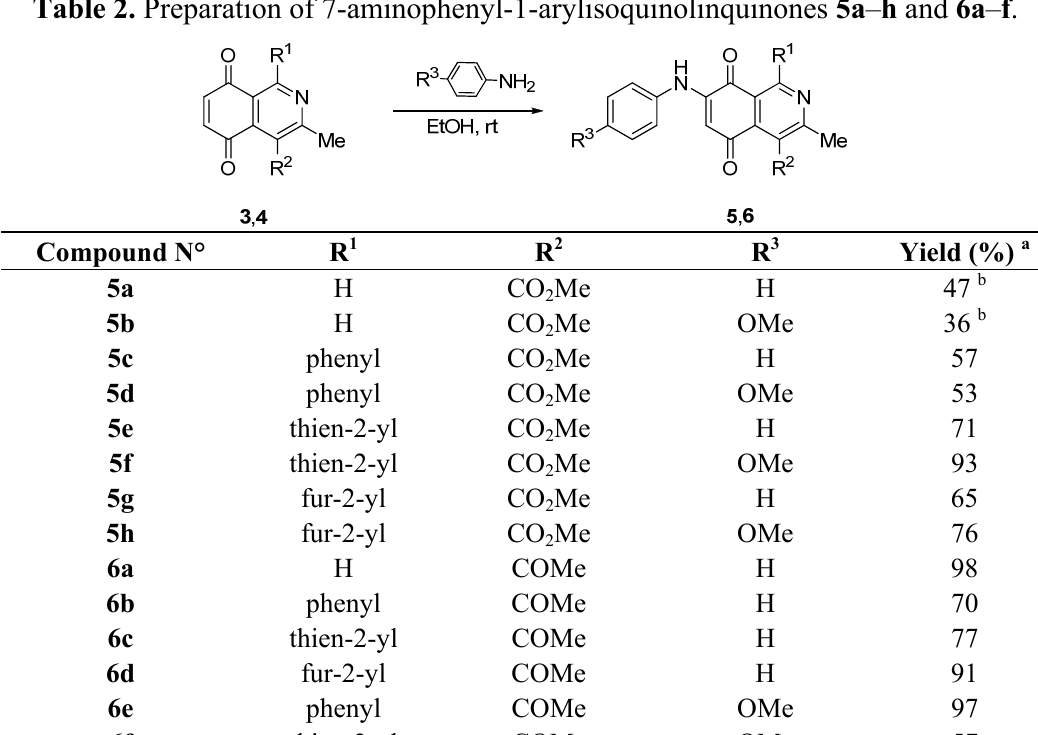
Table 2. Preparation of 7-aminophenyl-1-arylisoquinolinquinones 5a – h and 6a – f .